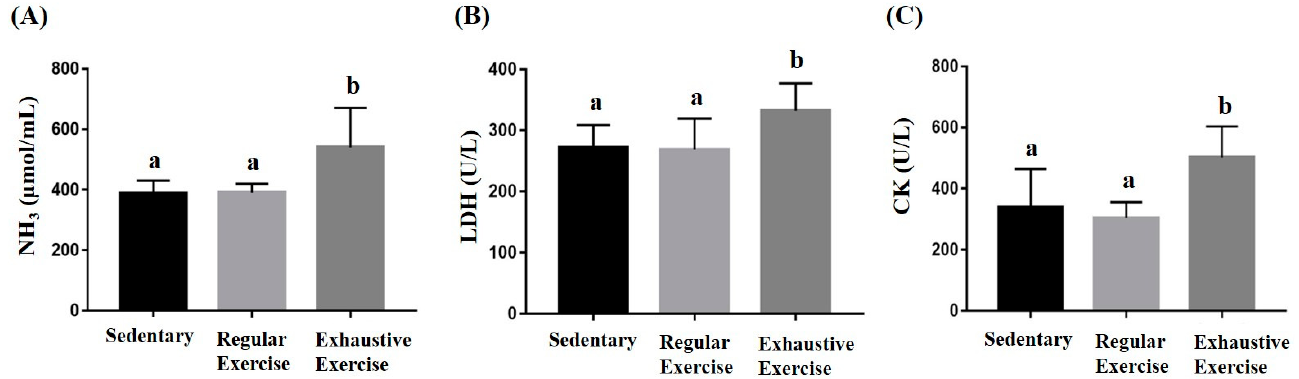
Figure 5. Effect of exercise and probiotic intervention on NH 3 ( A ), LDH ( B ), and CK ( C ) levels after an acute exercise challenge (20 min treadmill). Blood was immediately sampled after the exercise for biochemical assessments. Data are represented as mean ± standard deviation, and the columns with different letters (a, b) indicate significant difference at p < 0.05. Table 2. Effects of consecutive exhaustive exercise intervention on lactate metabolite profiles after an acute exercise chal- lenge.